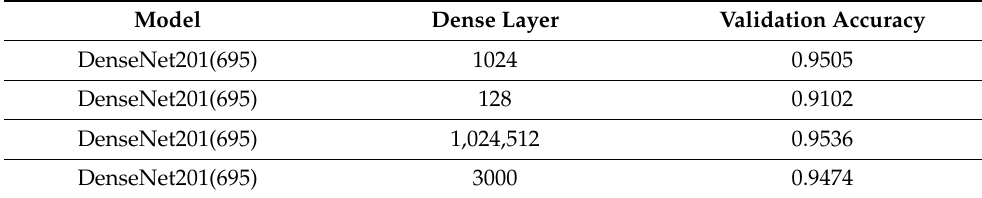
Table 9. Model classification